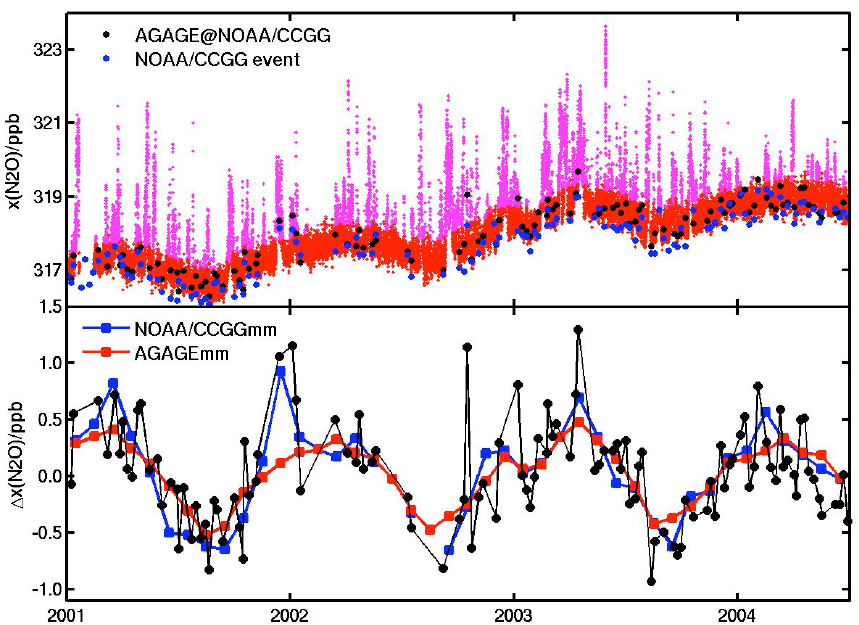
Fig. 3. (a) N 2 O data at Mace Head, Ireland from January 2001–June 2004. Warm colors show complete AGAGE in situ data. Magenta indicates data tagged as pollution events. Blue dots are NOAA/CCGG event (i.e., weekly flask) data. Black circles are AGAGE data subsampled at the time of NOAA/CCGG flask collection. (b) AGAGE data subsampled at the time of NOAA/CCGG flask collection. Solid squares show the monthly mean data for AGAGE and NOAA/CCGG. All data have been detrended with a 12-month centered running mean of their respective